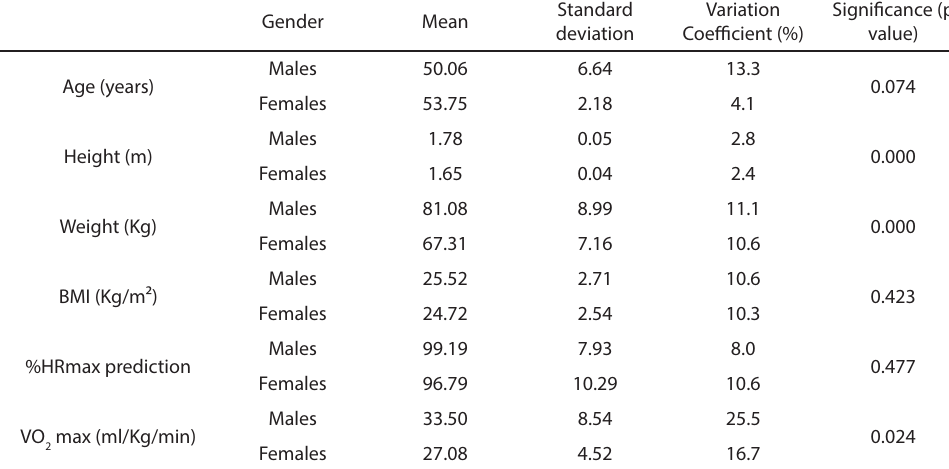
TABLE 1. Characteristics of the population (males n=18; females